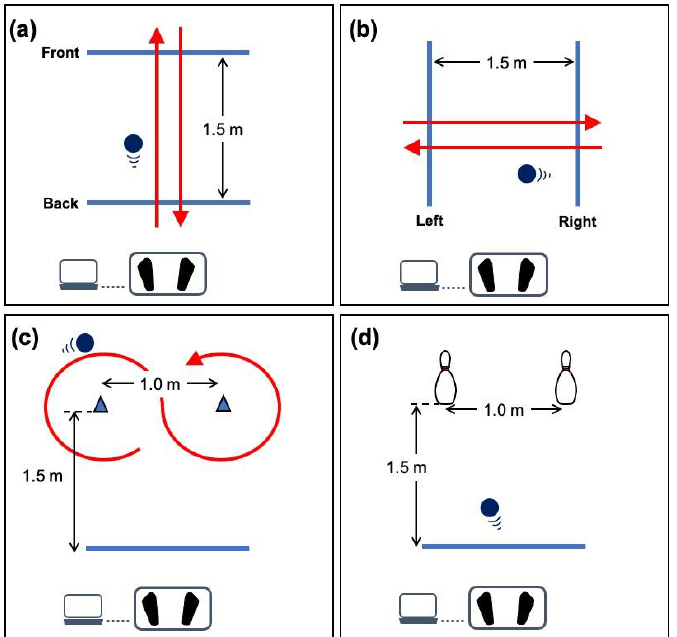
Figure 2. Basic balance exercises using LOCOBOT. Four typical exercises, ( a ) front–back, ( b ) left–right, ( c ) 8-turn, and ( d ) bowling, were examined. Each exercise was repeated five times continuously.